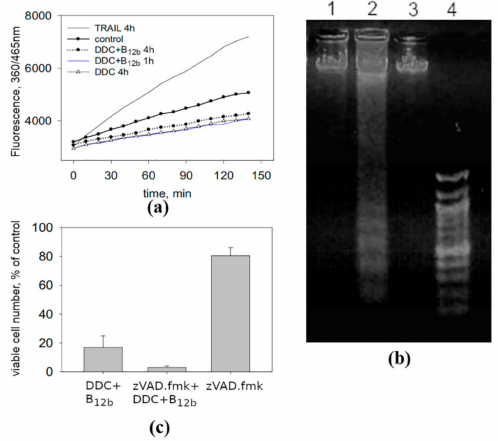
Figure 4. The absence of signs of apoptosis during initiation of cell death by a combination of 1 mM DDC with 25 µ M B 12b . ( a ) Inhibition of the activity of caspase-3 in HEp-2 cells incubated with DDC + B 12b . As a positive control, the recombinant protein izTRAIL significantly increased the activity of caspase 3. ( b ) The absence of internucleosomal DNA fragmentation in HEp-2 cells treated by the combination DDC + B 12b . 1—untreated control cells; 2—cells after 24 h of incubation with a combination of 1 mM dithiothriethol + 25 µ M B 12b , which causes apoptosis [18] (positive control); 3—cells after 24 h of incubation with DDC + B 12b ; 4—molecular weight markers. ( c ) The pan-caspase inhibitor zVAD.fmk did not protect cells from death induced by the combination DDC + B 12b . zVAD.fmk (50 µ M) was added to culture medium 1.5 h before the addition of DDC + B 12b for 6 h, after which the medium was replaced with fresh one and then after 48-h cultivation the cytotoxicity was evaluated. The data are the means ± s.e.m. of three separate